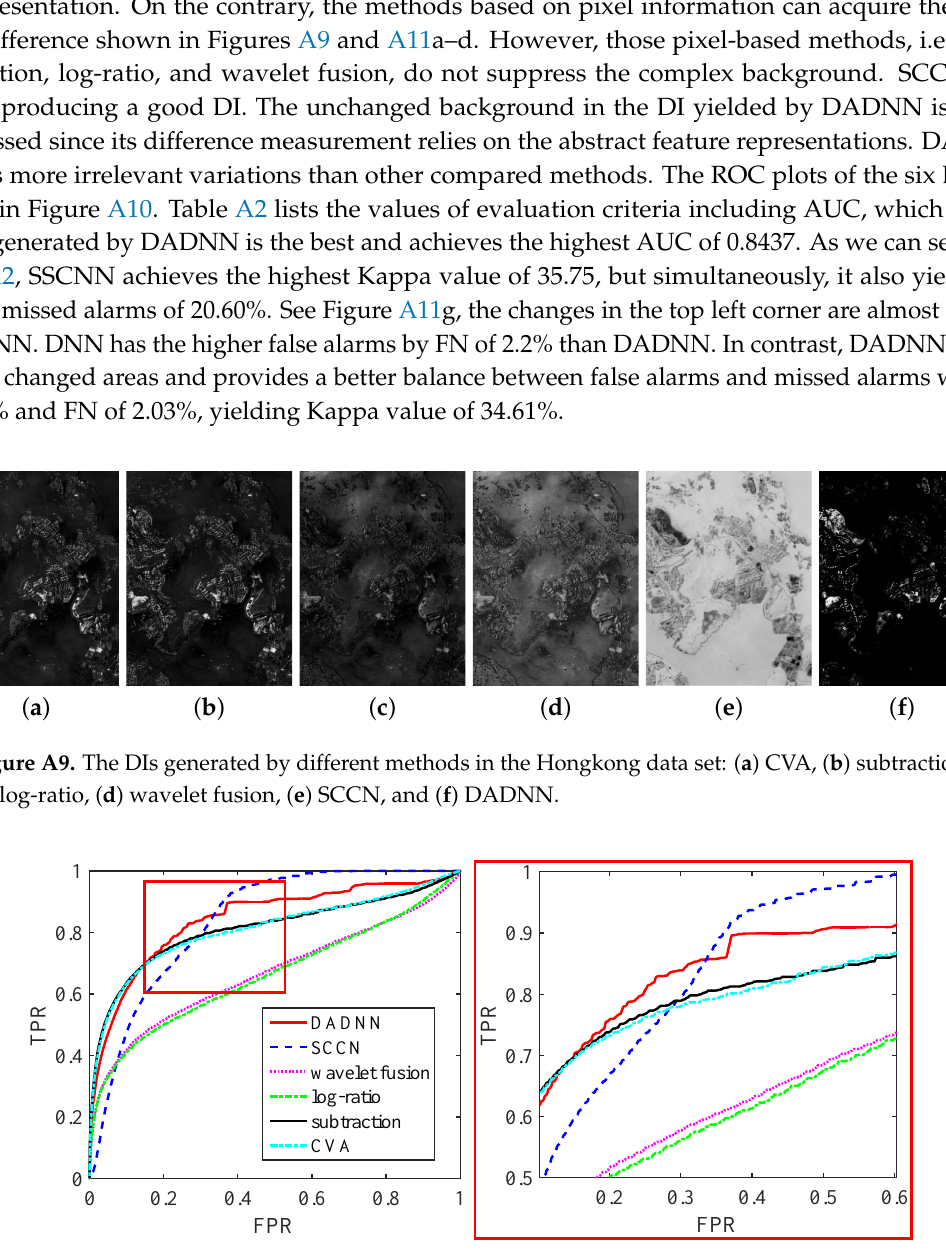
Figure A10. The ROC plots of the six difference maps on the Hongkong data set. The right shows corresponding enlarged areas of red boxes in the